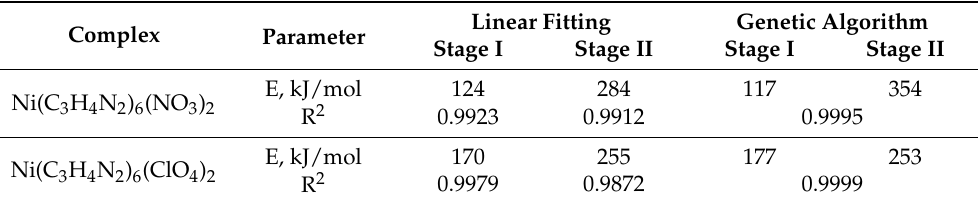
Table 2. Kinetic parameters of thermal decomposition of [Ni(C 3 H 4 N 2 ) 6 ](NO 3 ) 2 and [Ni(C 3 H 4 N 2 ) 6 ] (ClO 4 ) 2 complexes acquired using the Coats–Redfern